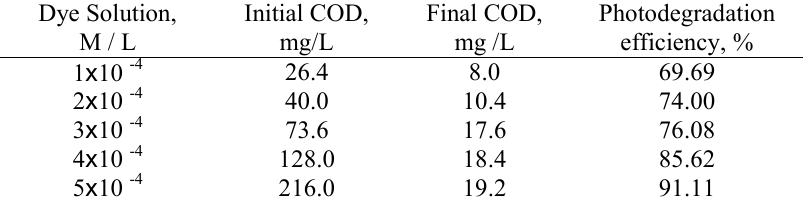
Table 3. Chemical Oxygen Demand (COD) in methyl blue